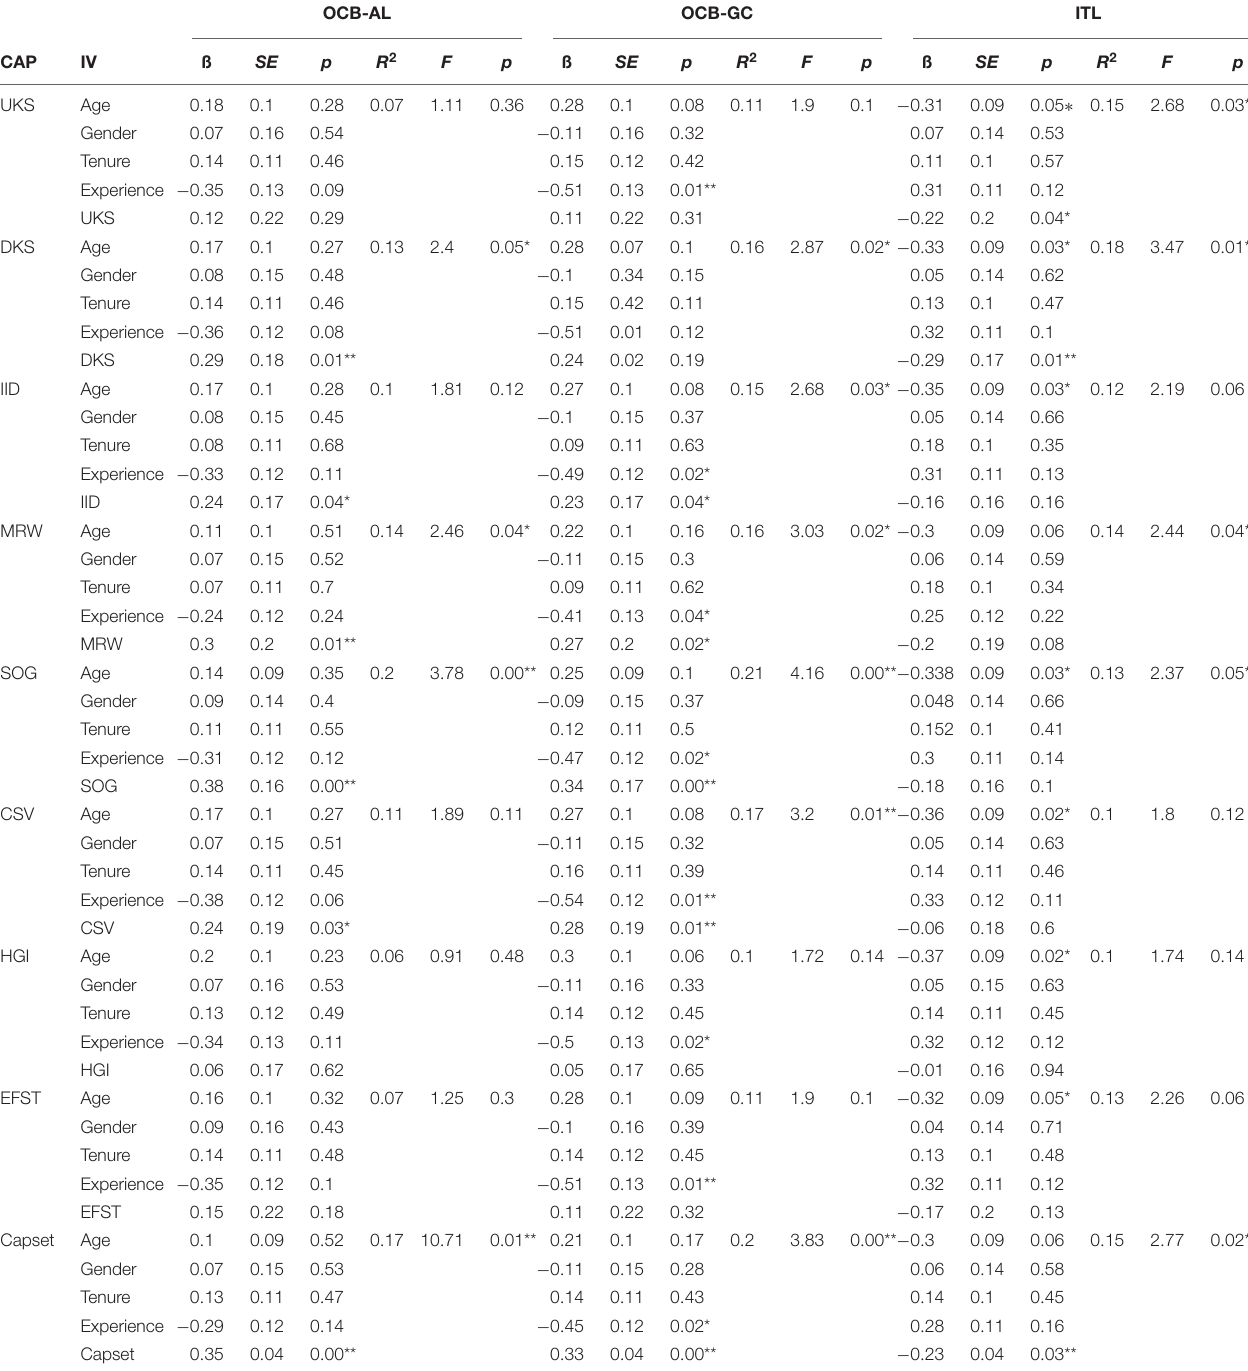
TABLE 5 | Multiple regression analyses of demographic variables, capabilities, and organizational